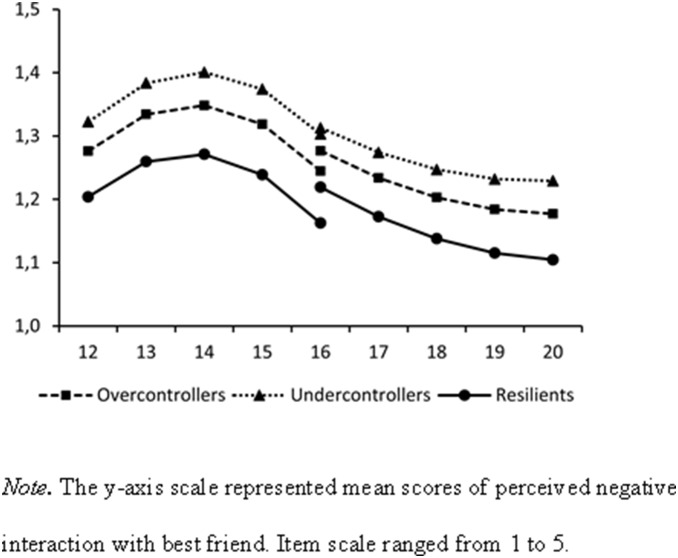
Estimated Developmental Changes in Adolescent Friendship Negative Interaction by Adolescent Personality Types.